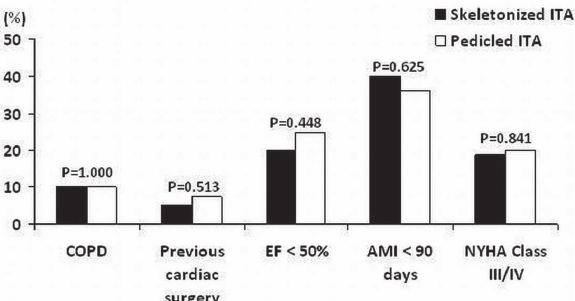
Fig. 2 – Description of preoperative clinical characteristics in elderly undergoing CABG. ITA = internal thoracic artery; CABG = coronary artery bypass graft; COPD = chronic obstructive pulmonary disease; EF = ejection fraction; AMI = acute myocardial